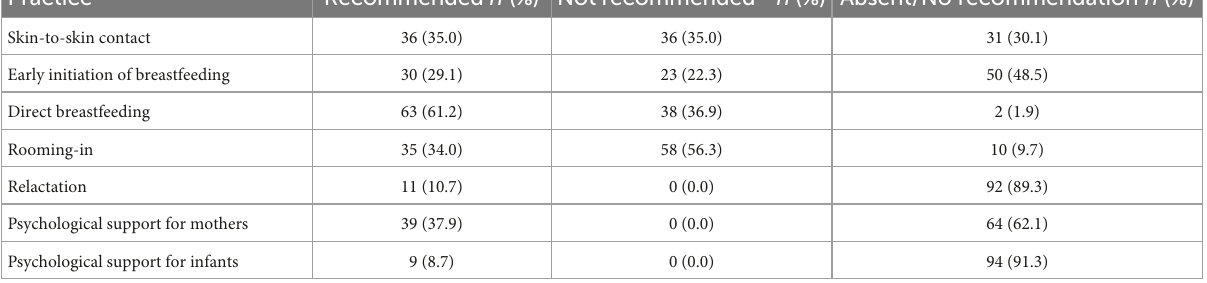
TABLE 1 Number and frequency of guidance recommending, not recommending, and providing no recommendation on skin-to-skin contact, early initiation of breastfeeding, direct breastfeeding, rooming-in, relactation, and provision of psychological support for mothers and infants ( N =